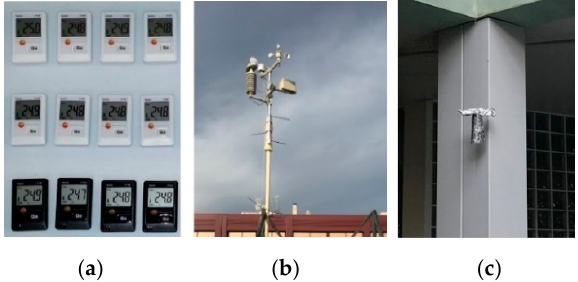
Figure 1. Instruments are measuring devices used for tests. ( a ) sensors of measurement (temperature and humidity); ( b ) meteorological station, to be placed in the building cover; ( c ) protective caps to prevent overheating of the sensor by direct